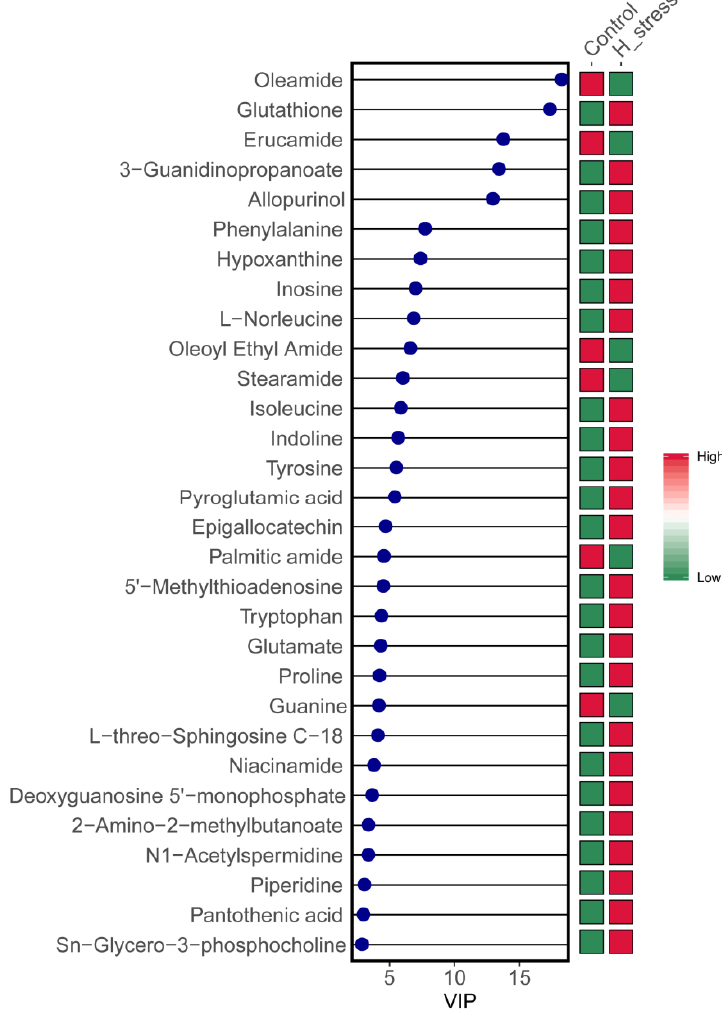
Figure 3. Variable importance in projection (VIP) score analysis plot of intracellular important metabolite in immortalized bovine mammary cell lines (MAC-T). The top 30 important metabolites were arranged from top to bottom according to intracellular concentration. The red box represents a high concentration of the molecule and the green box represents low concentration.